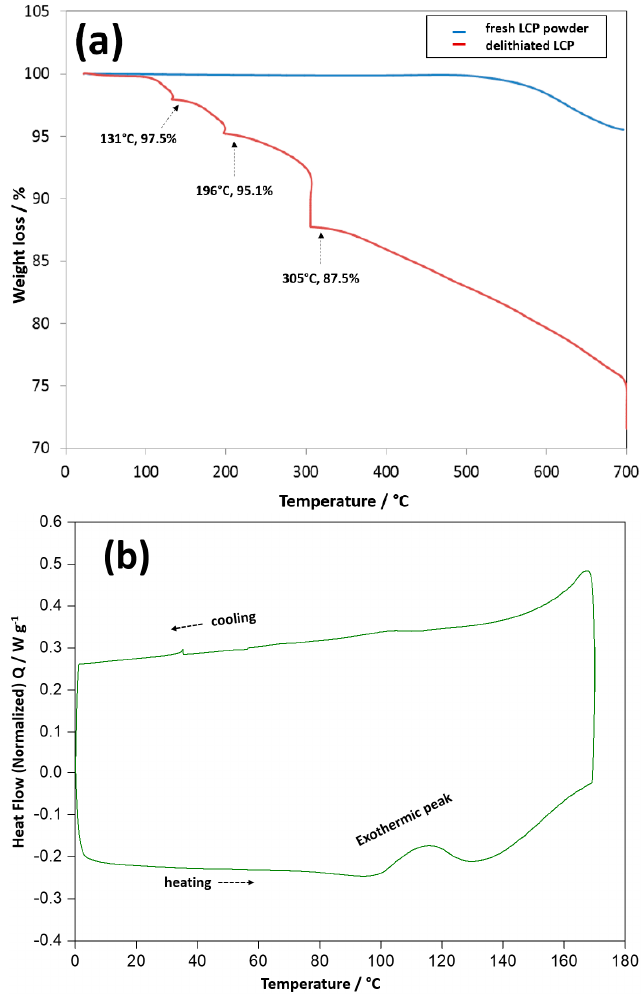
Figure 5. TGA curves of the fresh (lithiated) and delithiated LCP samples ( a ) and DSC curve of delithiated LCP powders ( b ).